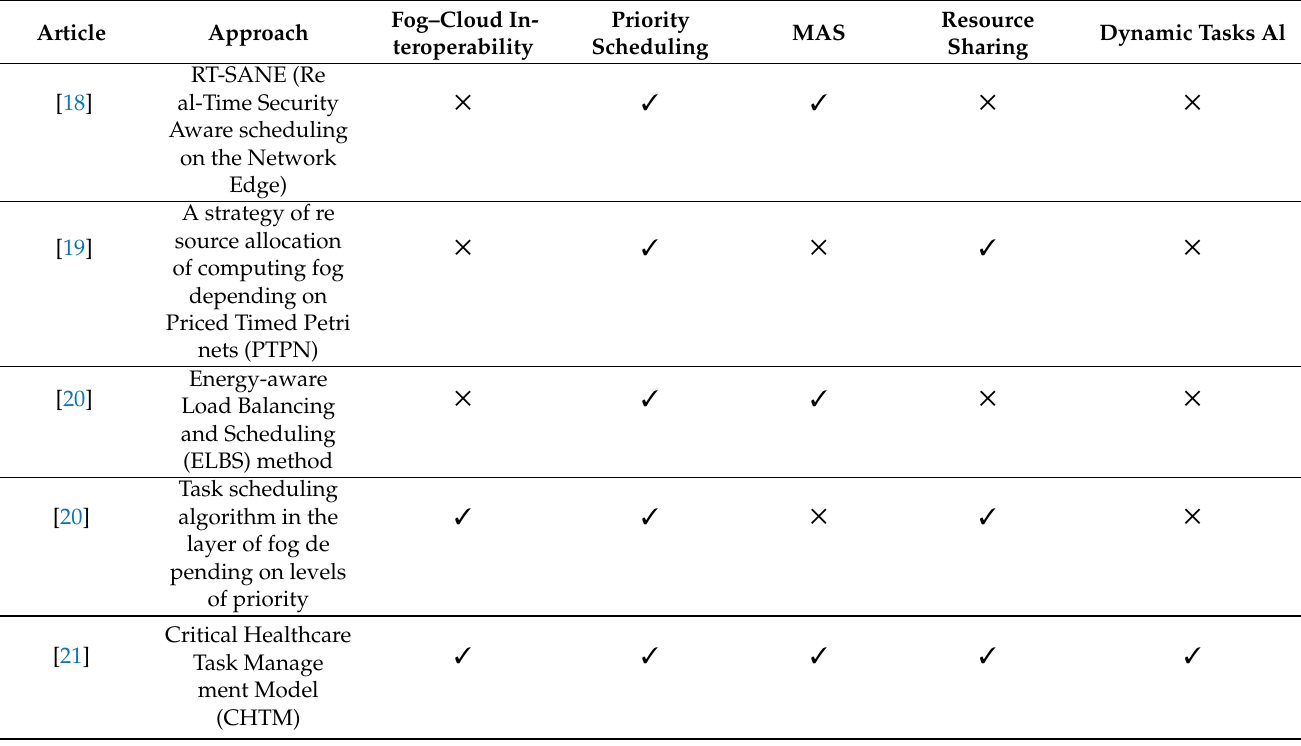
Table 1. Related works